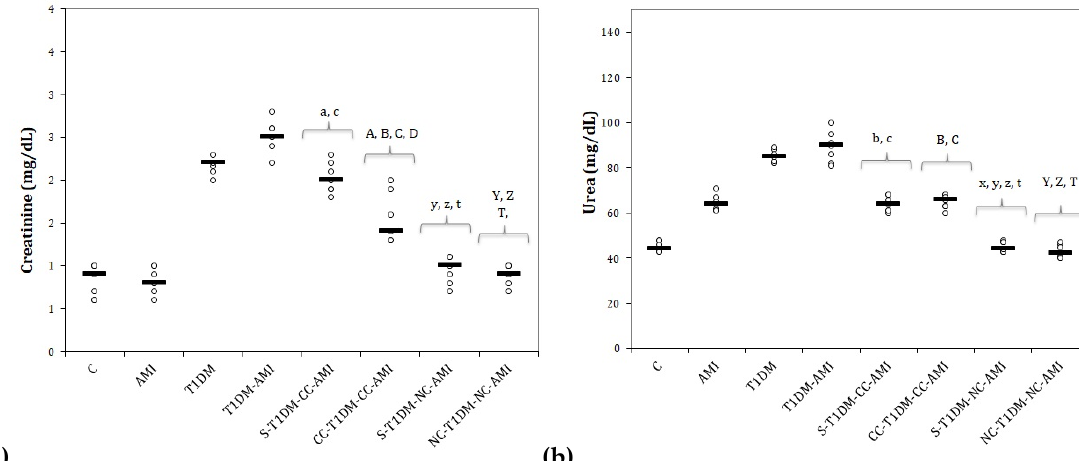
Figure 7. Serum levels of kidney function parameters: ( a ) Creatinine; ( b ) Urea. C—control; AMI—acute myocardial in-